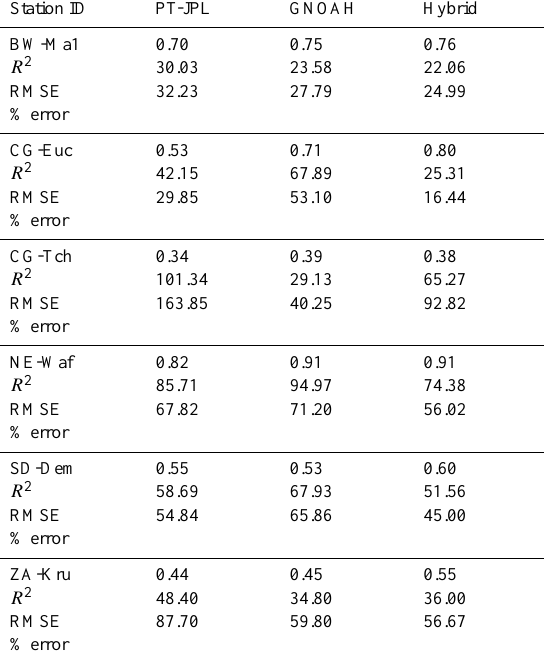
Table 9. Summary results from the comparison of ob- served monthly LE to the PT-JPL, Noah, and hybrid (PT-JPL LE C +GNOAH LE (I,S)